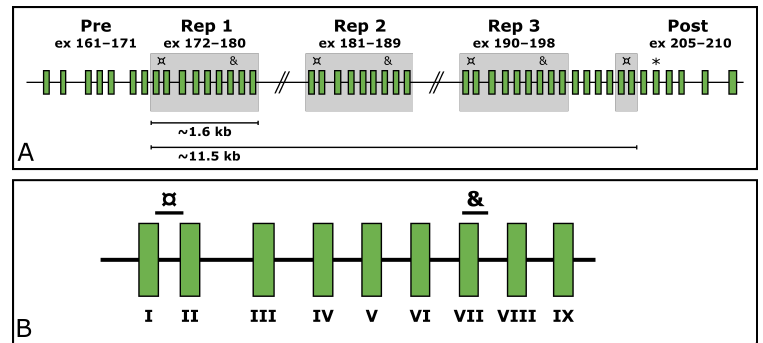
Figure 1. The structure of the TTN SD region. ( A ) shows the repeated blocks shaded in grey. The custom ddPCR assays targeting the TTN SD region exons I and VII are marked with ¤ and & respectively. The targeted exons downstream of the segmental duplication are marked with an asterisk (*). ( B ) shows a zoom-in on the repeated block along with the target locations of the assays. The exons of the repeated block have been assigned Roman numerals for simplification; e.g., exon I represents the first exon of each block (172/181/190/203), and exon VII represents the seventh exon of each block